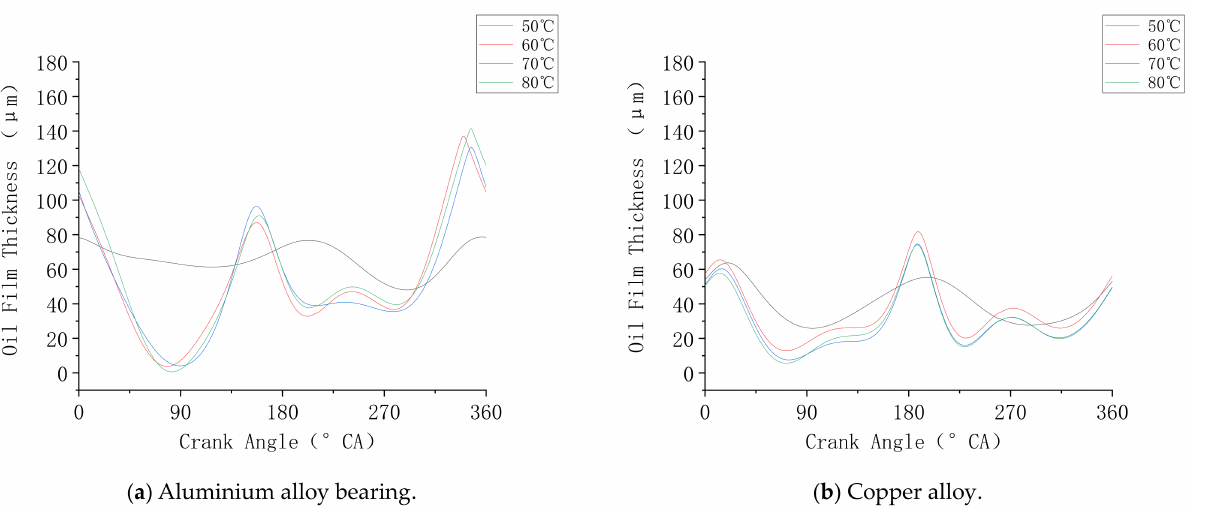
Figure 7. Comparison of the oil film thickness of the bearing with the different oil inlet temperatures.